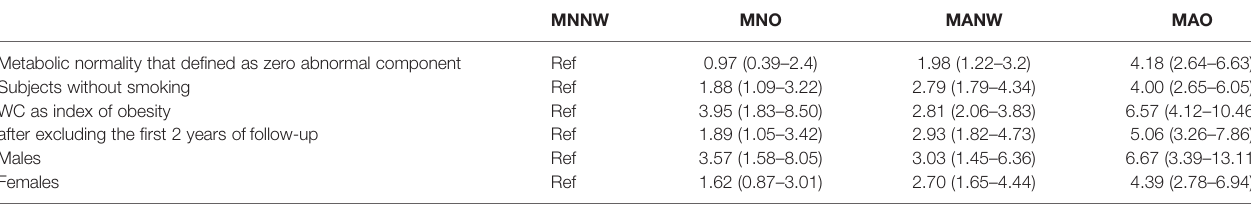
Adjusted for age, sex, smoking, drinking, physical activity, and family history of disease. MNNW, metabolically normal and normal weight; MANW, metabolically abnormal but normal weight; MNO, metabolically normal but obesity/overweight; MAO, metabolically abnormal and obesity/overweight; WC, waist